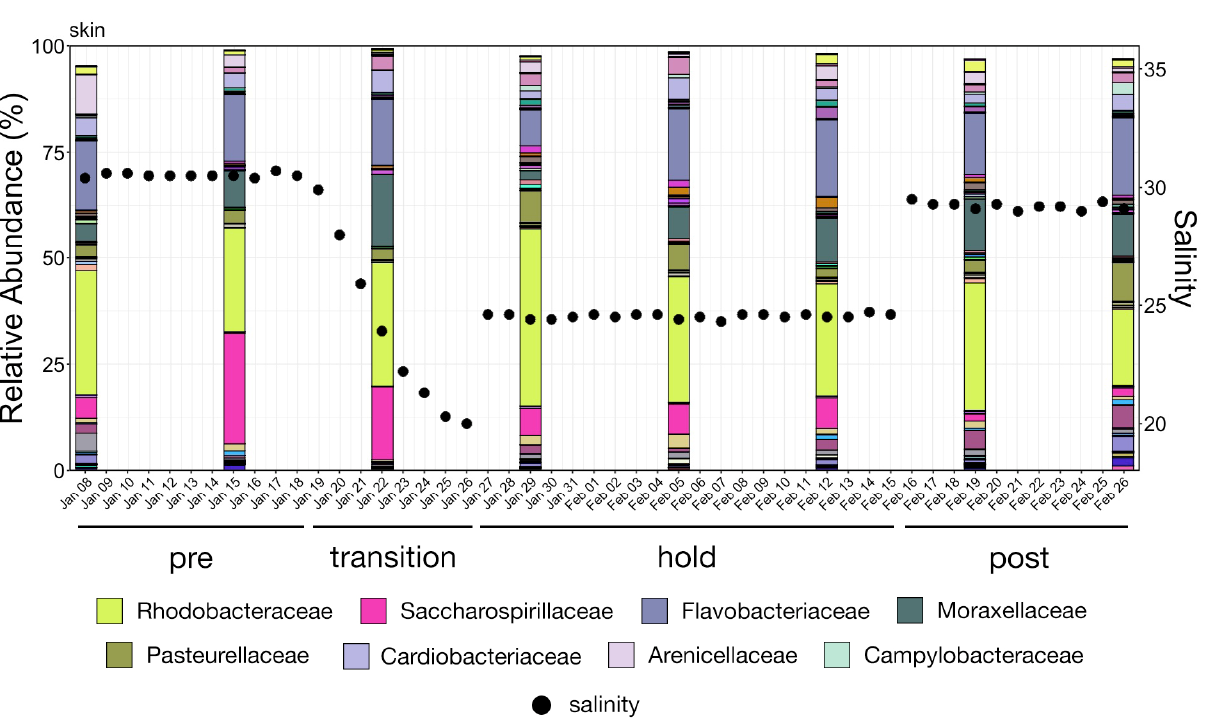
Figure 8. Barplot demonstrating the mean relative abundances of families within skin samples throughout the water change. Salinities for each day are overlayed with black points. The 8 most abundant families across are samples are displayed in the legend.